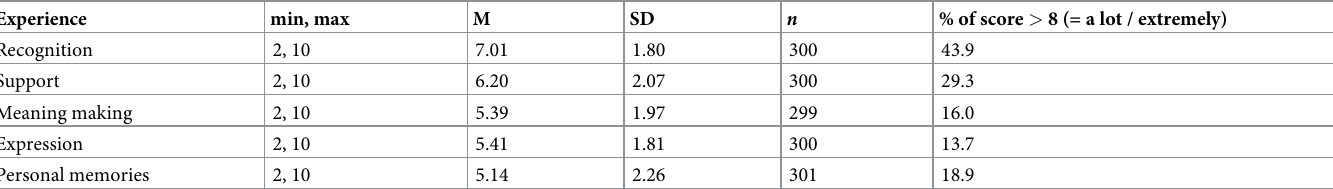
Table 4. Mechanisms that are experienced during the